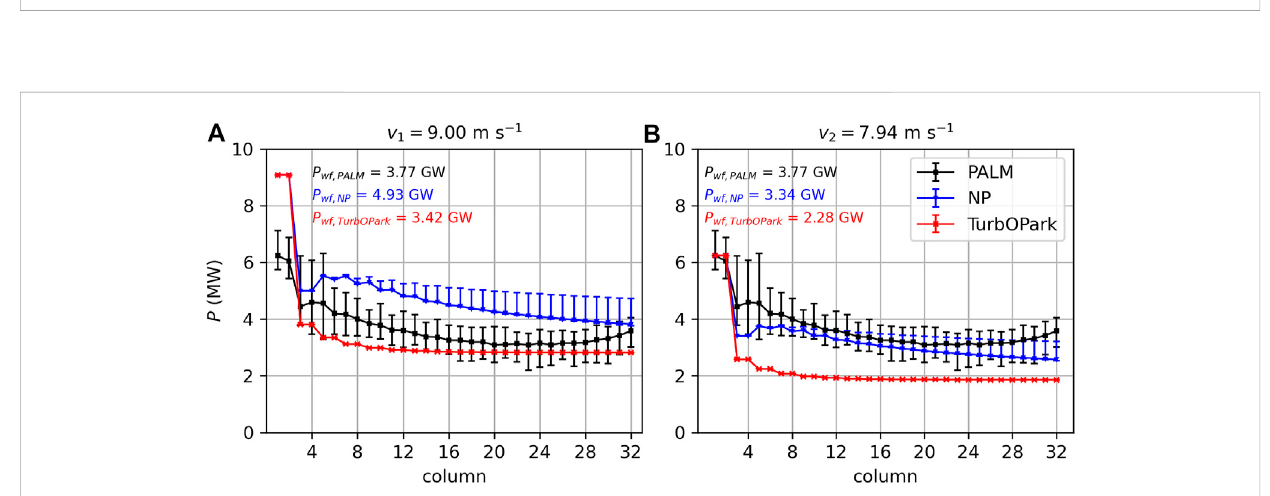
FIGURE 11 Wind turbine power of theLES modelPALM, theNiayifar and Porté-Agelmodel (NP) and the TurbOPark model. The markers represent thecolumn- wiseaveragedpowerandtheerrorbarsrepresentthemaximalandminimalpowerintherespectivewindfarmcolumn.In (A) thereferencewindspeedfor thewake modelsissettothein fl owwindspeedathub heightoftheLES(9.00 m · s − 1 ).Inthe (B) thereference windspeedisreducedto7.94 m · s − 1 ,which is the wind speed 2.5 D upstream of the fi rst column averaged along the wind farm width in PALM. The total wind farm powers ( P wf ) are also